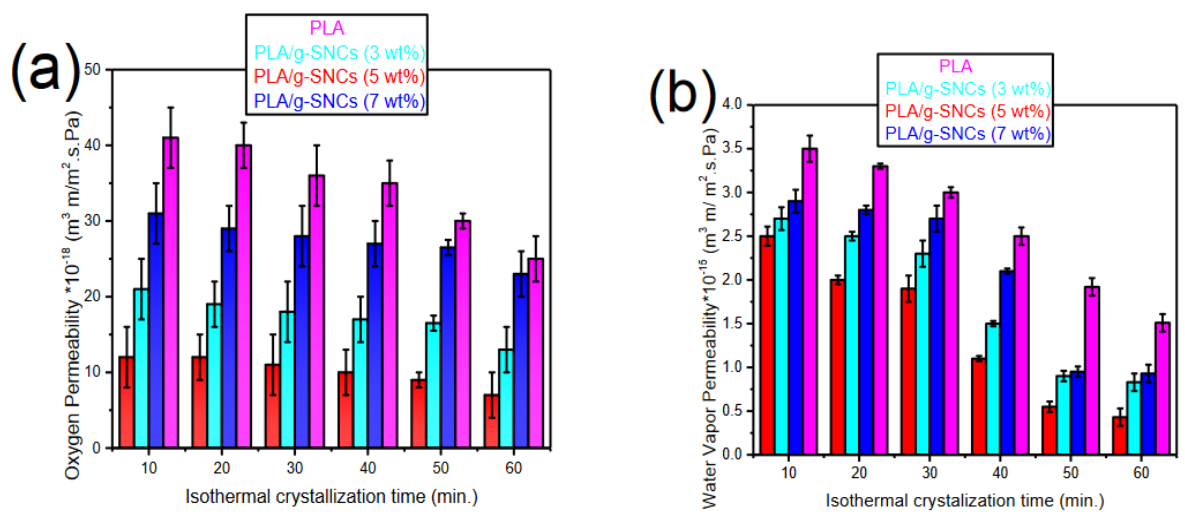
Figure 7. ( a ) Oxygen and ( b ) water vapour permeability of neat PLA and PLA/SNC-g-LA nanocom- posites crystallized at 130 °C at various crystallization time.